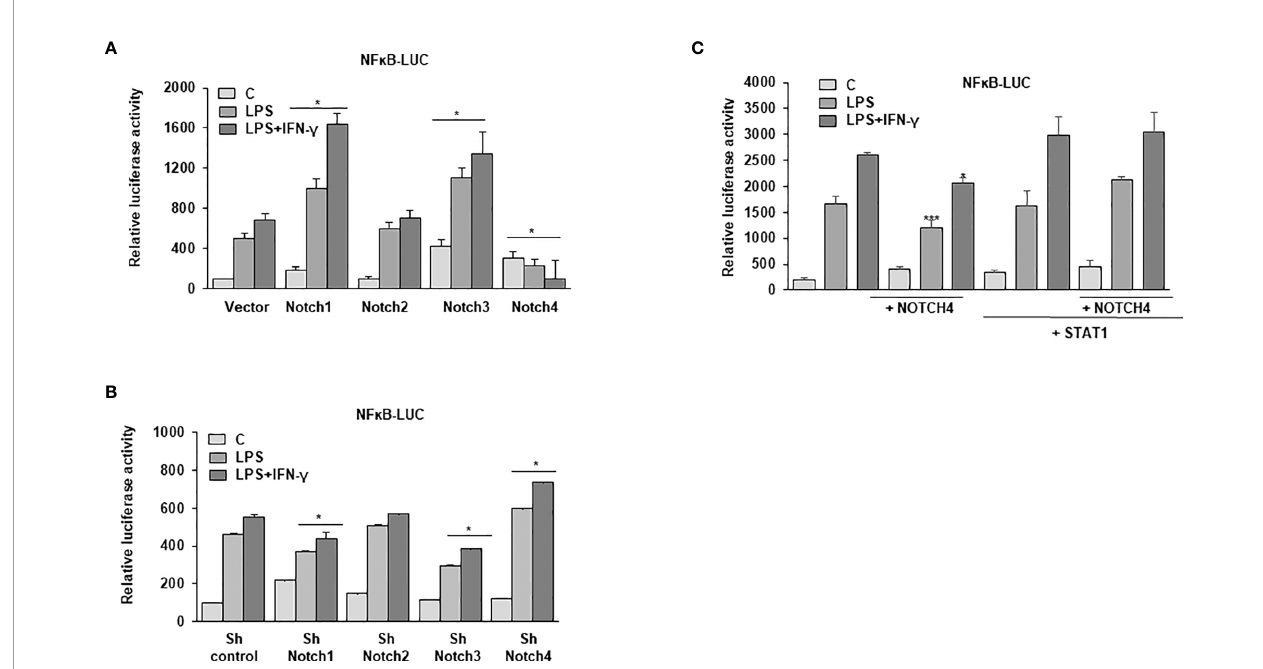
FIGURE 8 | Analysis of the effect of NOTCH4 expression on NF- k B activation in LPS and IFN- g activated macrophages. (A) Analysis of luciferase activity in Raw 264.7 cells transiently transfected with an NF- k B luciferase reporter gene (NF- k B-luc) and speci fi c expression vectors for Notch receptor genes or their corresponding empty vectors, or (B) speci fi c shRNAs for the different Notch receptor genes or control shRNA. One day after transfection, cells were stimulated with LPS (100 ng/ml) or LPS and IFN- g (10 U/ml) for 24 h before analysis. The means ± SD of three independent experiments are shown. One-way ANOVA/Bonferroni ’ s post-tests were performed. *p<0.05 compared to the corresponding control transfected cells (vector or sh control). (C) Analysis of luciferase activity in Raw 264.7 cells transiently transfected with an NF- k B luciferase reporter gene (NF- k B-luc) and speci fi c expression vectors for Notch4 receptor or STAT1 genes or their corresponding empty vectors. One day after transfection, cells were stimulated with LPS (100 ng/ml) or LPS and IFN- g (10 U/ml) for 24 h before analysis. The means ± SD of three independent experiments are shown. One-way ANOVA/Bonferroni ’ s post-tests were performed. *p<0.05 and ***p<0.001, compared to the corresponding activated (LPS or LPS and IFN- g ) Notch4 untransfected